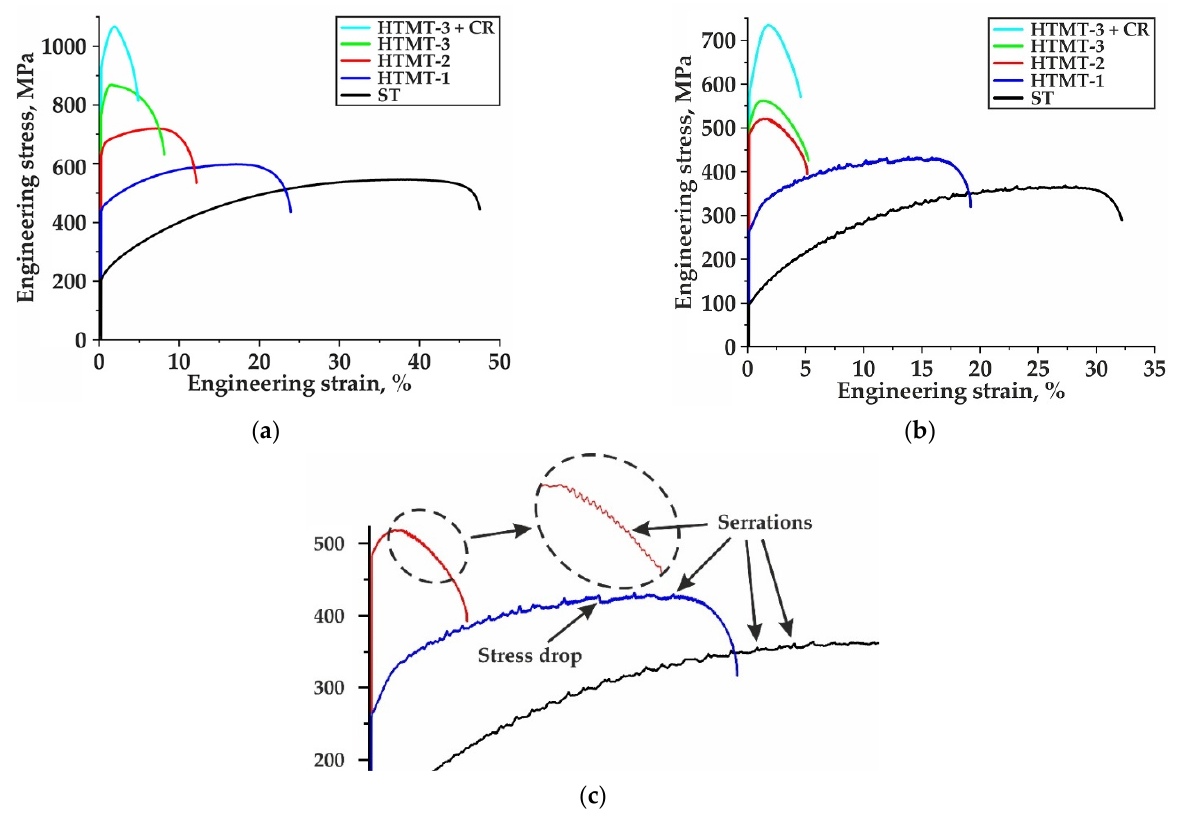
Figure 9. Engineering stress–engineering strain curves of some treated steel samples: tension at 20 ( a ), tension at 650 °C ( b ), magnified part of curves from the image ( b ) with serration flow ( c ).